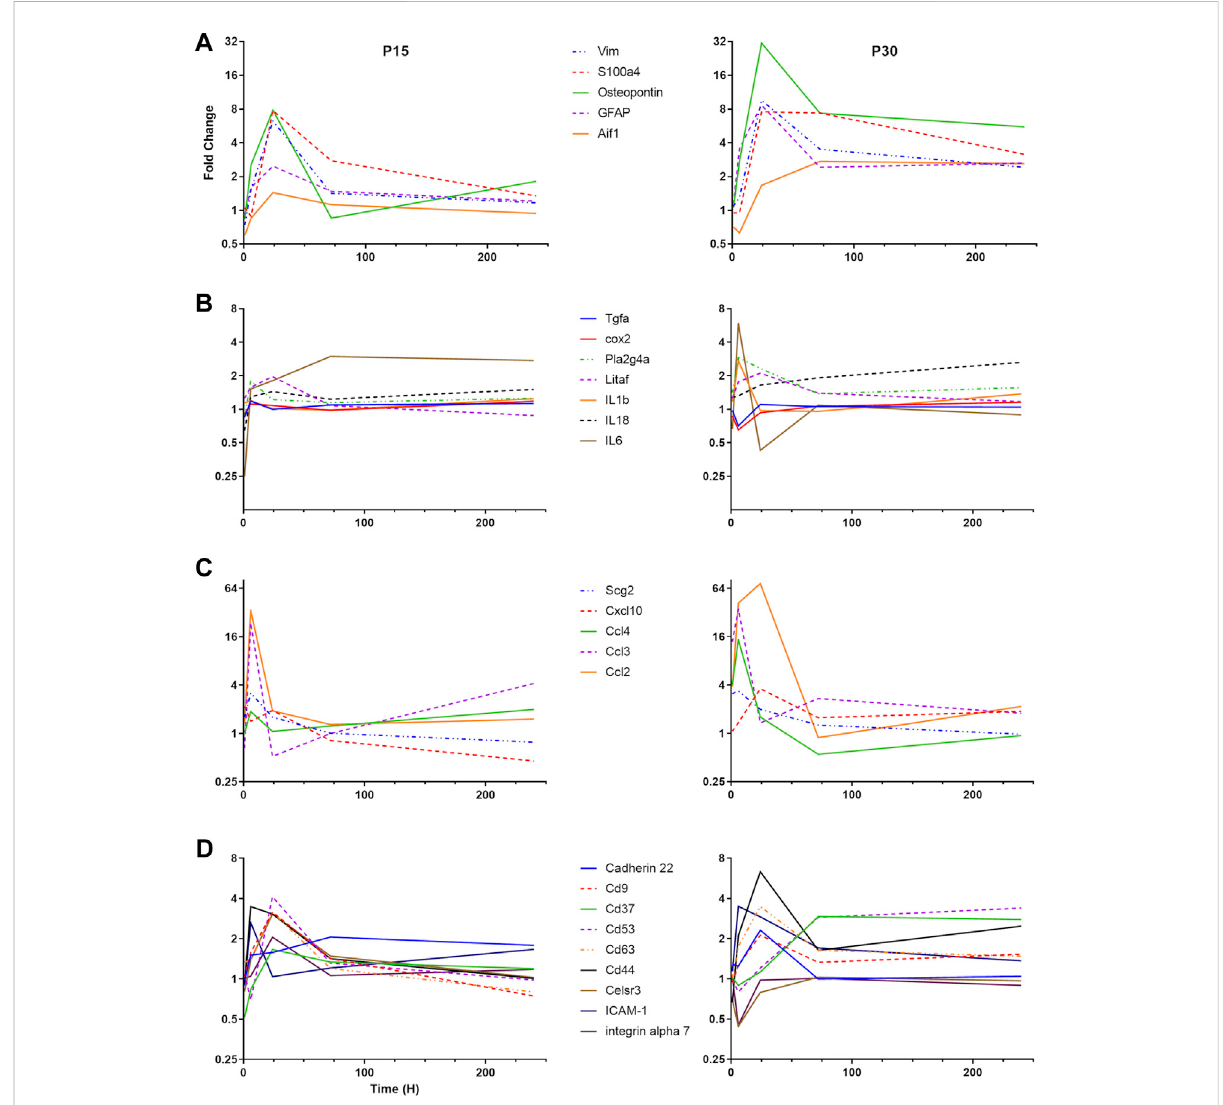
FIGURE 3 Differential time course of various groups of in fl ammatory genes in P15 and P30. (A) Microglial and astrocyte markers (Aif1, GFAP, Osteopontin, S100a4, and VIM). (B) Cytokines and eicosanoid pathways (IL-1 β , IL-6, IL-18, LITAF, TGF- β R1, TNF R1, PLA2G4A, and COX2). (C) Chemokines (CCL2, CCL3, CCL4, CXCL10, and Scg2). (D) Adhesion molecules (Cadherin 22, CD9, CD37, CD 53, CD63, CD44, Celsr3, ICAM-1, and Integrin α